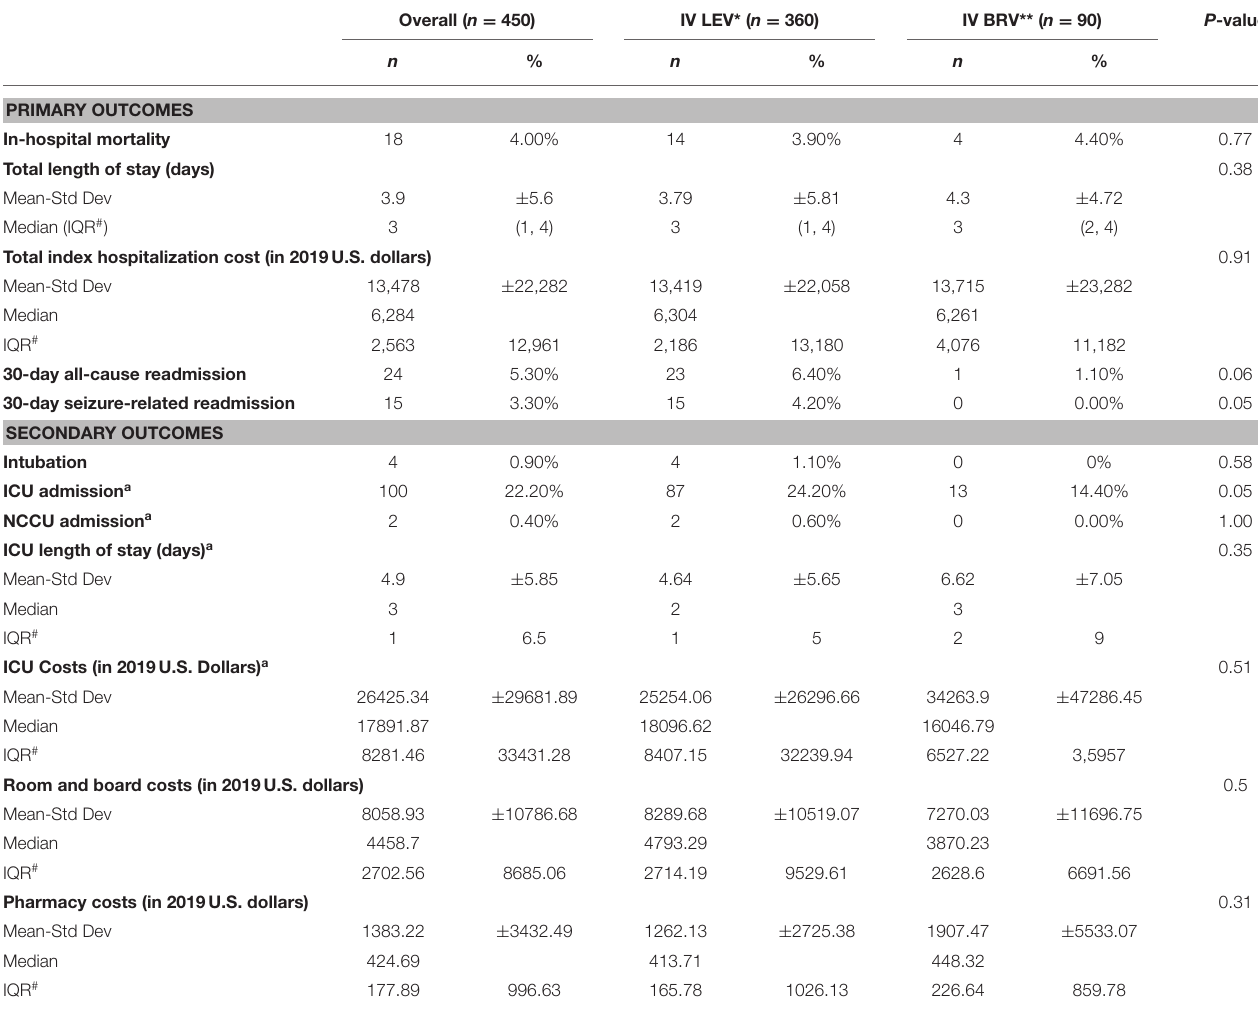
TABLE 3 | Unadjusted results for primary and secondary outcomes by treatment status. Overall ( n = 450) IV LEV* ( n = 360) IV BRV** ( n = 90) P